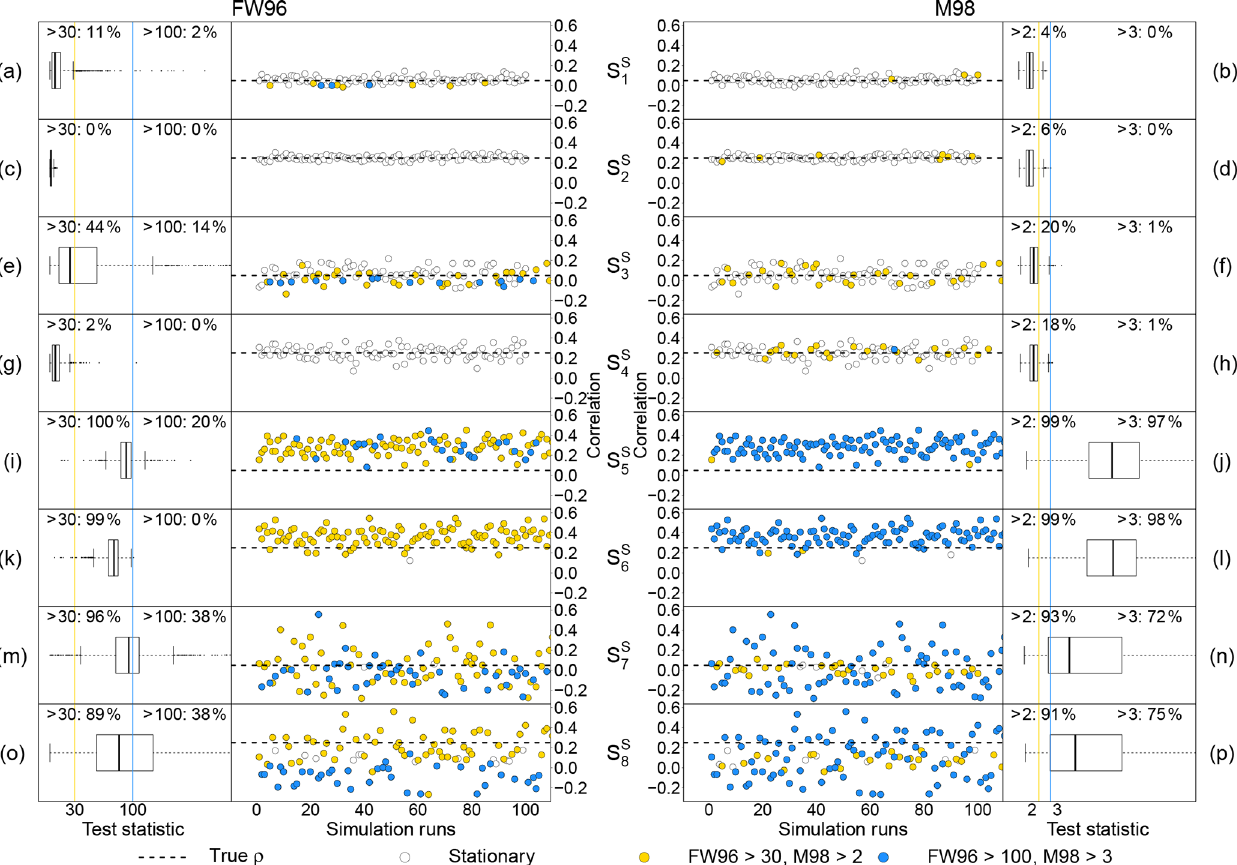
Figure 9. Performance evaluation of the stationarity tests by Foken and Wichura (1996, FW96) and by Mahrt (1998, M98) in each of the simulated S S scenarios described in Sect. 3.1.3. Left and right panels show the distribution of the FW96 and M98 test statistics, i = 1 ,..., 8 respectively, in 999 simulation runs; percentage values are reported at the top of panels (a) – (p) ; yellow and blue vertical lines indicate threshold values (30% and 100% for FW96, 2 and 3 for M98; see Sect. 2.2.3 for more details). The middle panels show the distribution of the test statistic as a function of the correlation between variables in the first 100 simulation runs; yellow and blue points indicate simulations when the test statistic exceeds the corresponding threshold values; the horizontal dashed line indicates the pre-fixed true correlation, ρ , used in